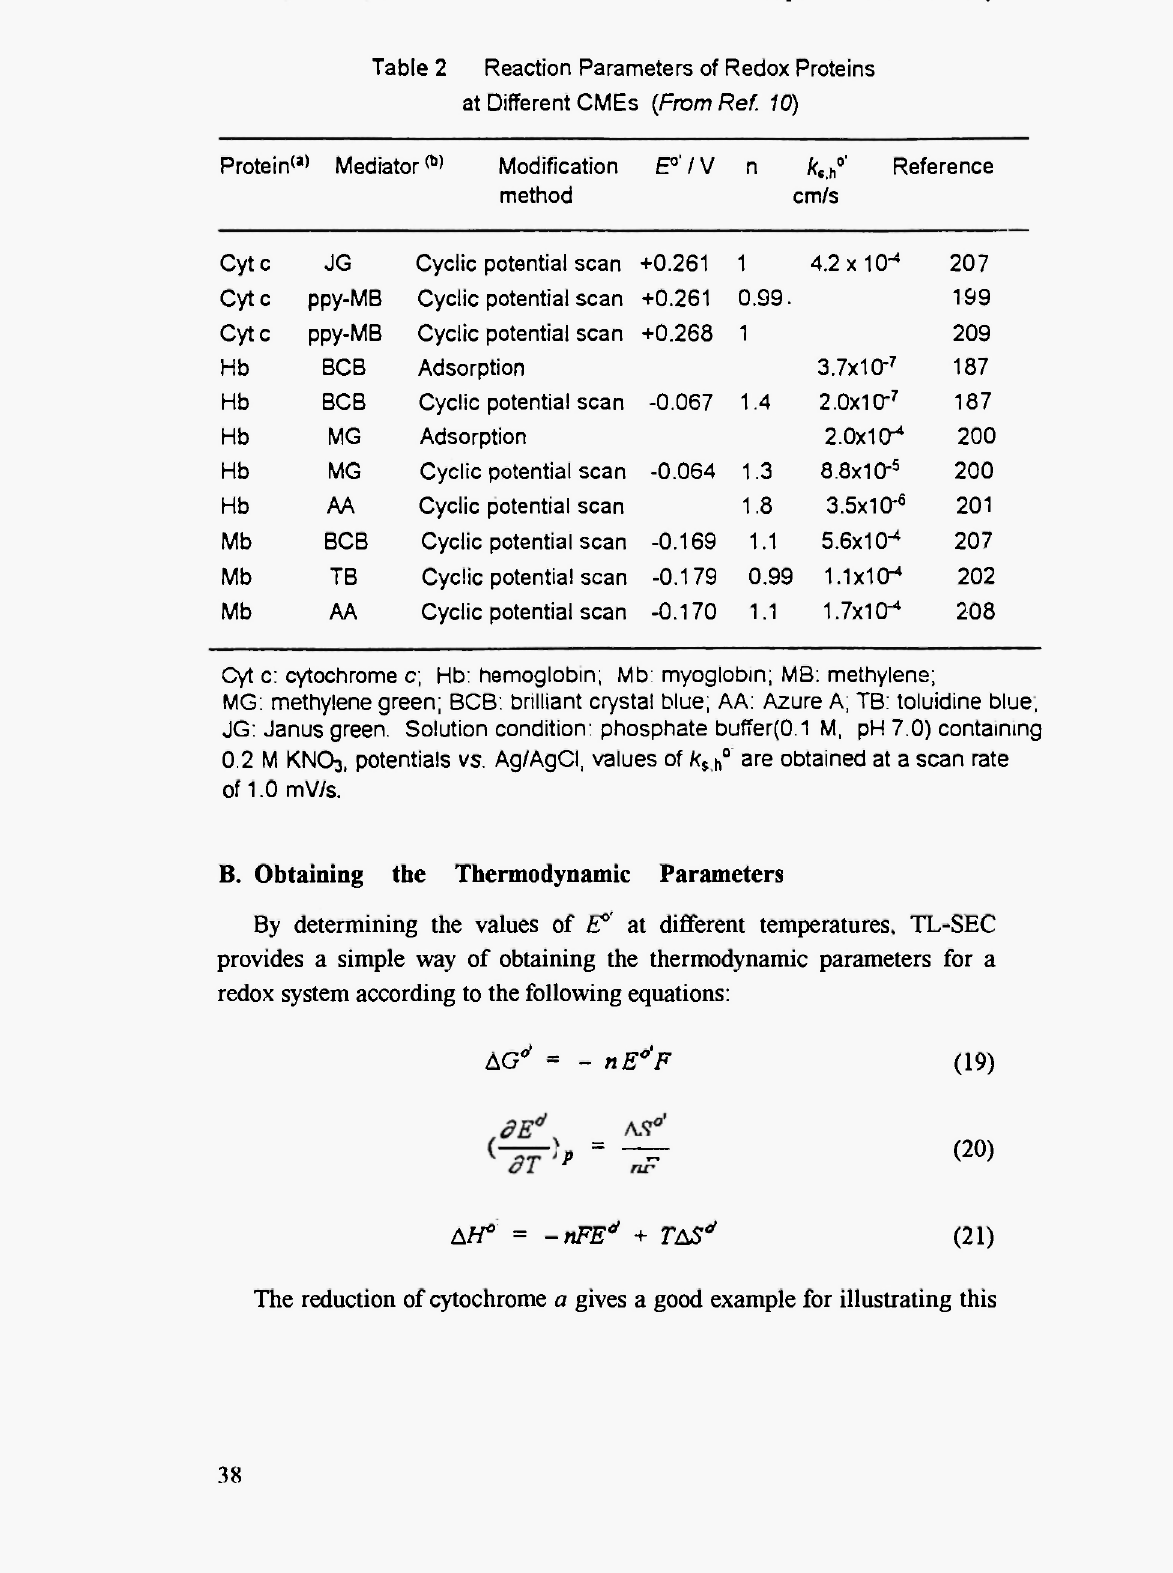
Reaction Parameters of Redox Proteins at Different C M Es {From Ref.